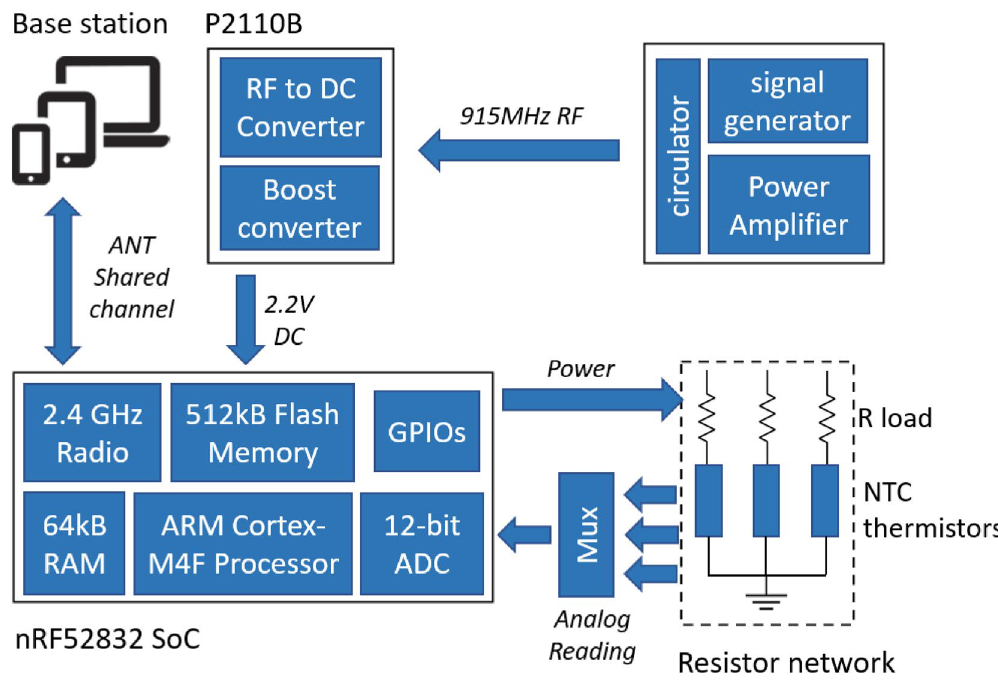
Figure 4. Block diagram of the wireless sensing